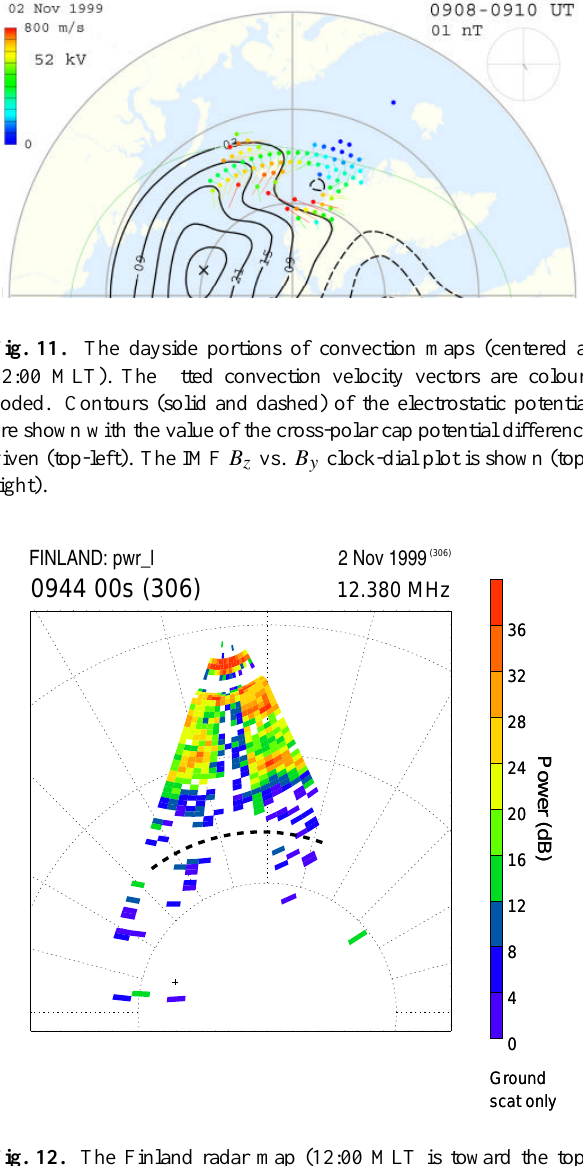
Fig. 12. The Finland radar map (12:00 MLT is toward the top) showing the ground-scatter-power signatures of TIDs. The radar was located in the afternoon sector just past 12:00 MLT. The ap- proximate axis of the flow channel as observed at 09:00 UT is su-